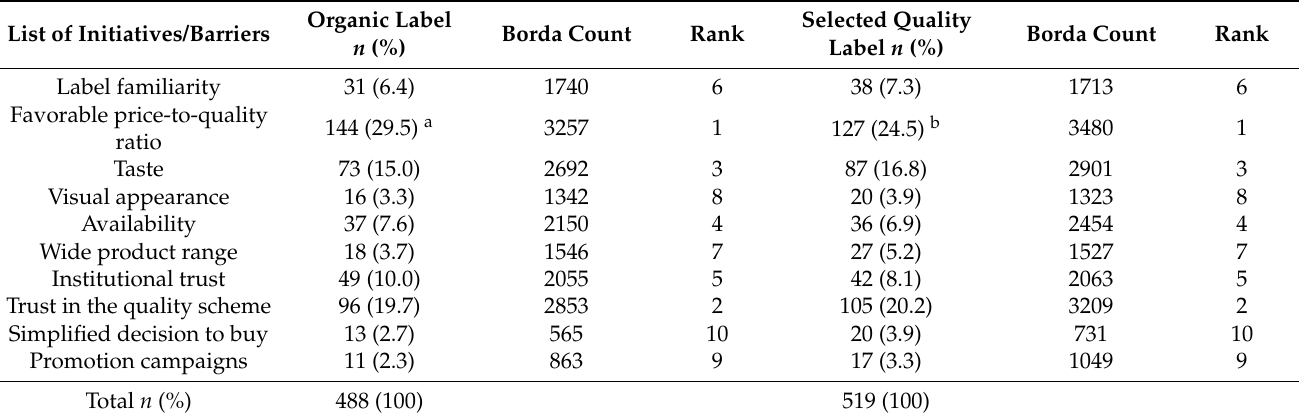
Table 3. Ranking of Factors Determining the Purchase of Certified Organic Food or Food under the National Quality Scheme “Selected Quality” ( n = 1007; two